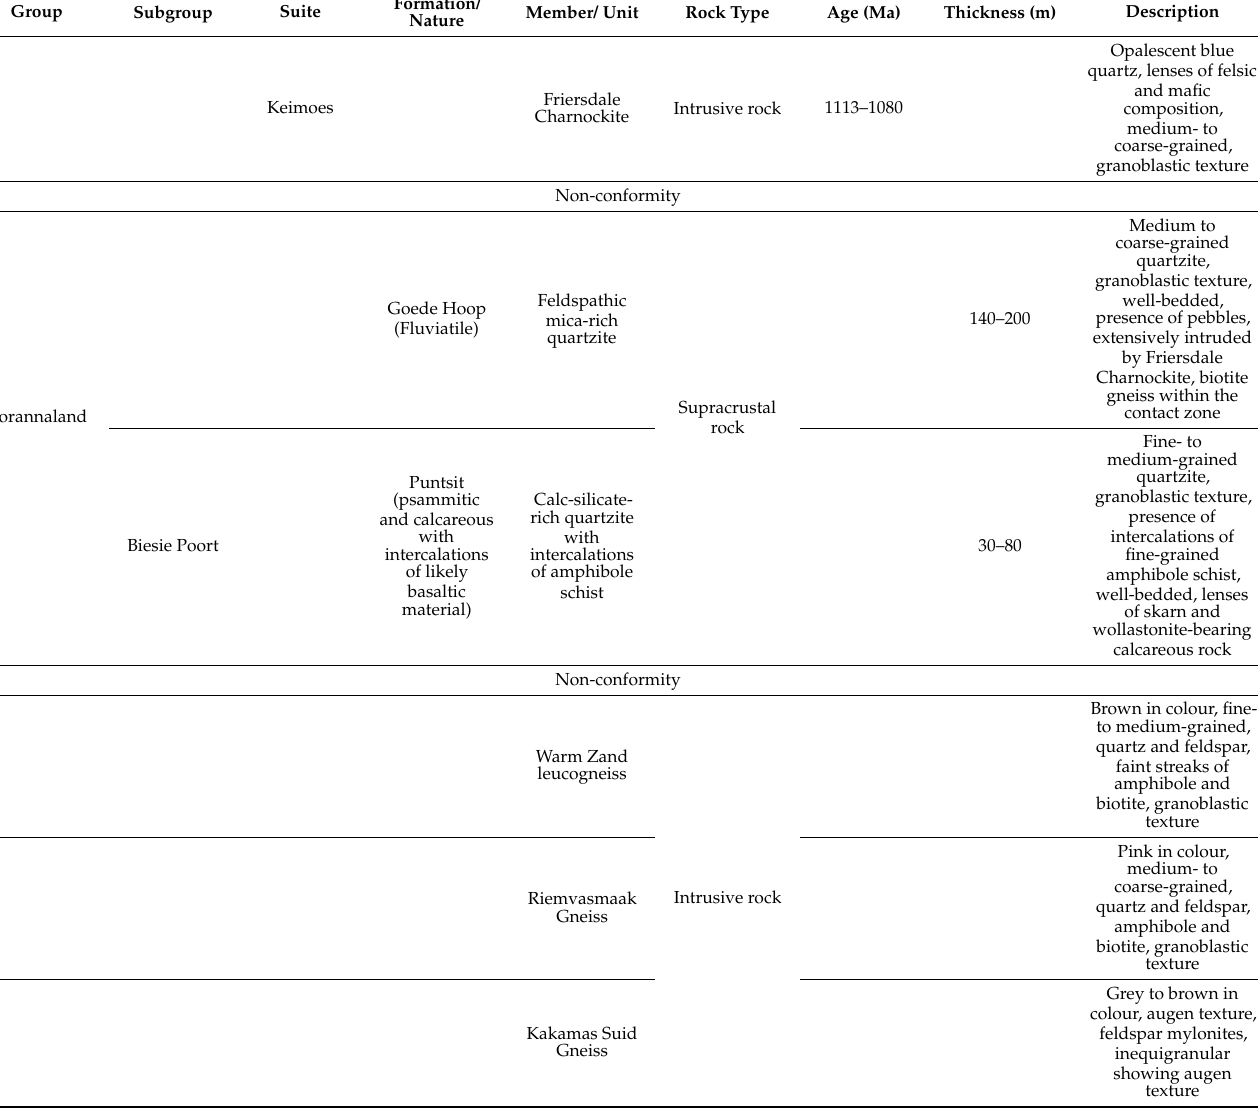
Table 1. Subdivision of the lithostratigraphic units of the South Central Zone in the Kakamas Domain, eastern Namaqua Sector. Summary after